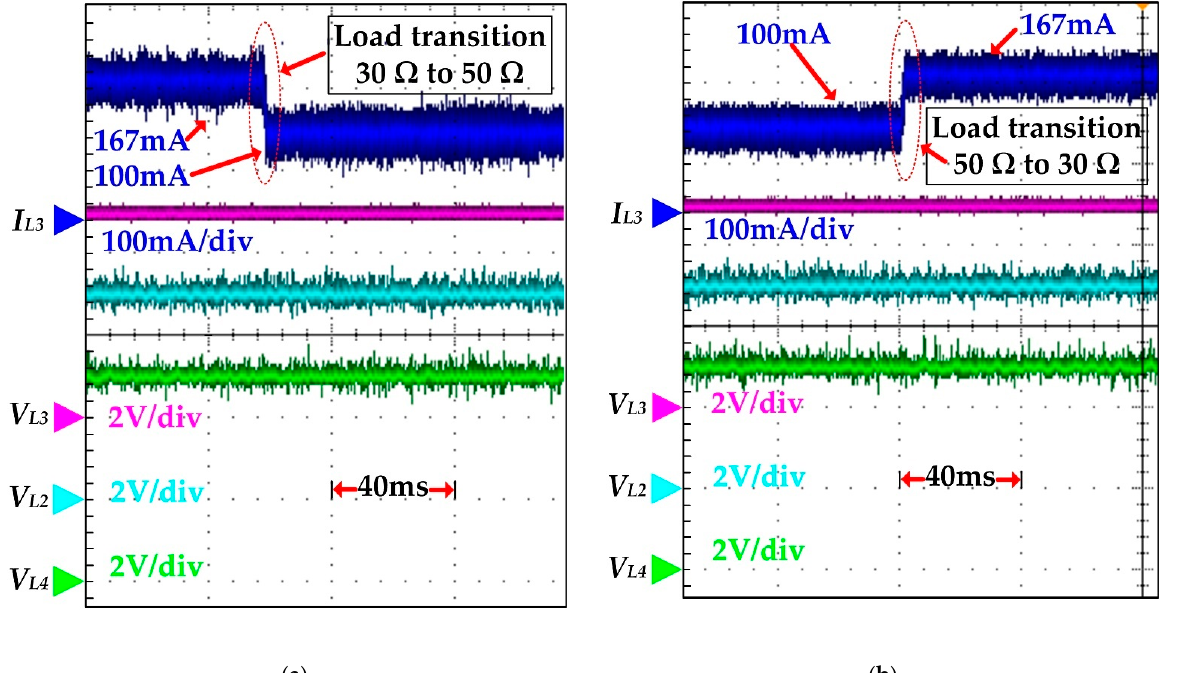
Ω to 50 Ω and ( b ) R L3 = 30